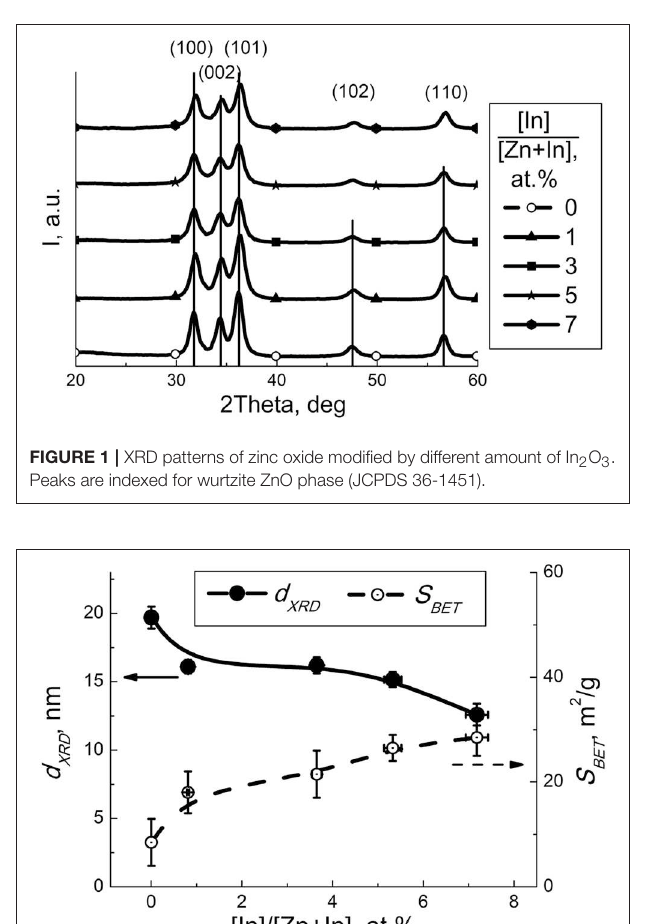
mode vibrations of ZnO (700–1,100 cm − 1 ) (Boccuzzi et al., 1981). The multicomponent bands at 1,300–1,700 cm − 1